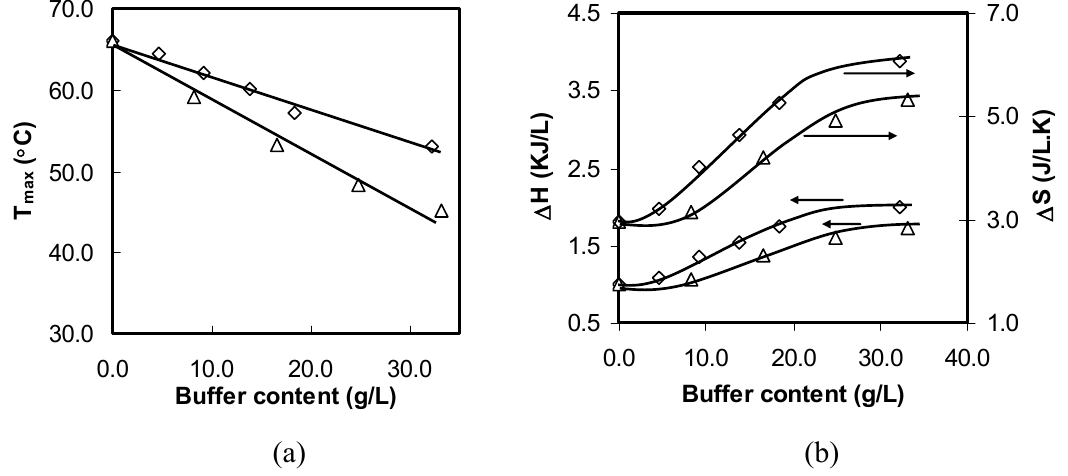
; ( b ) Δ H and Δ max